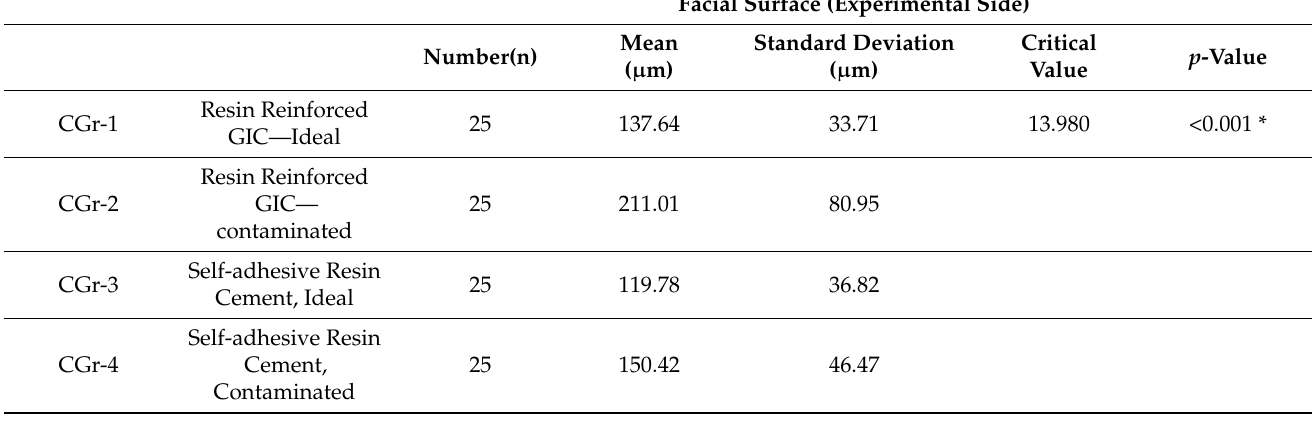
Table 2. Comparison of microleakage between different luting cements on experimental side of facial surface (n = 25).